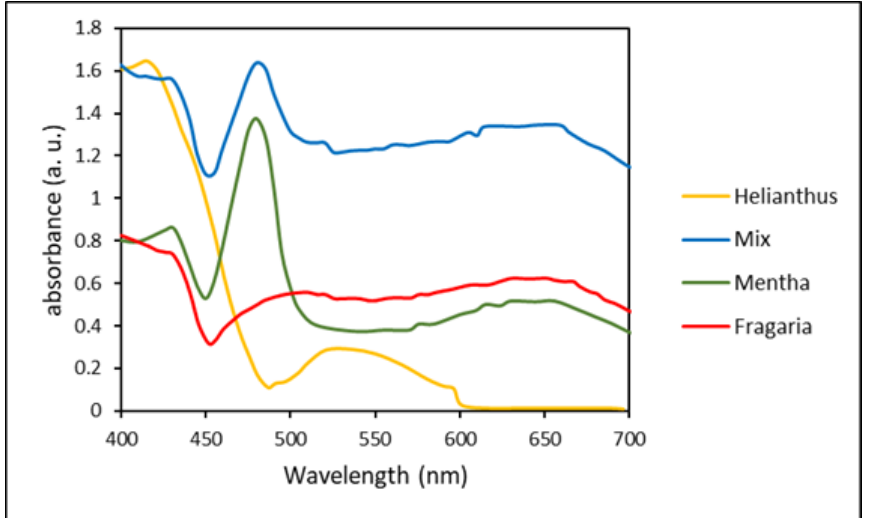
Figure 12. UV-Vis absorption spectra of Mentha leaves, Helianthus annuus, Fragaria, and a mixture of the three showing various peak locations.